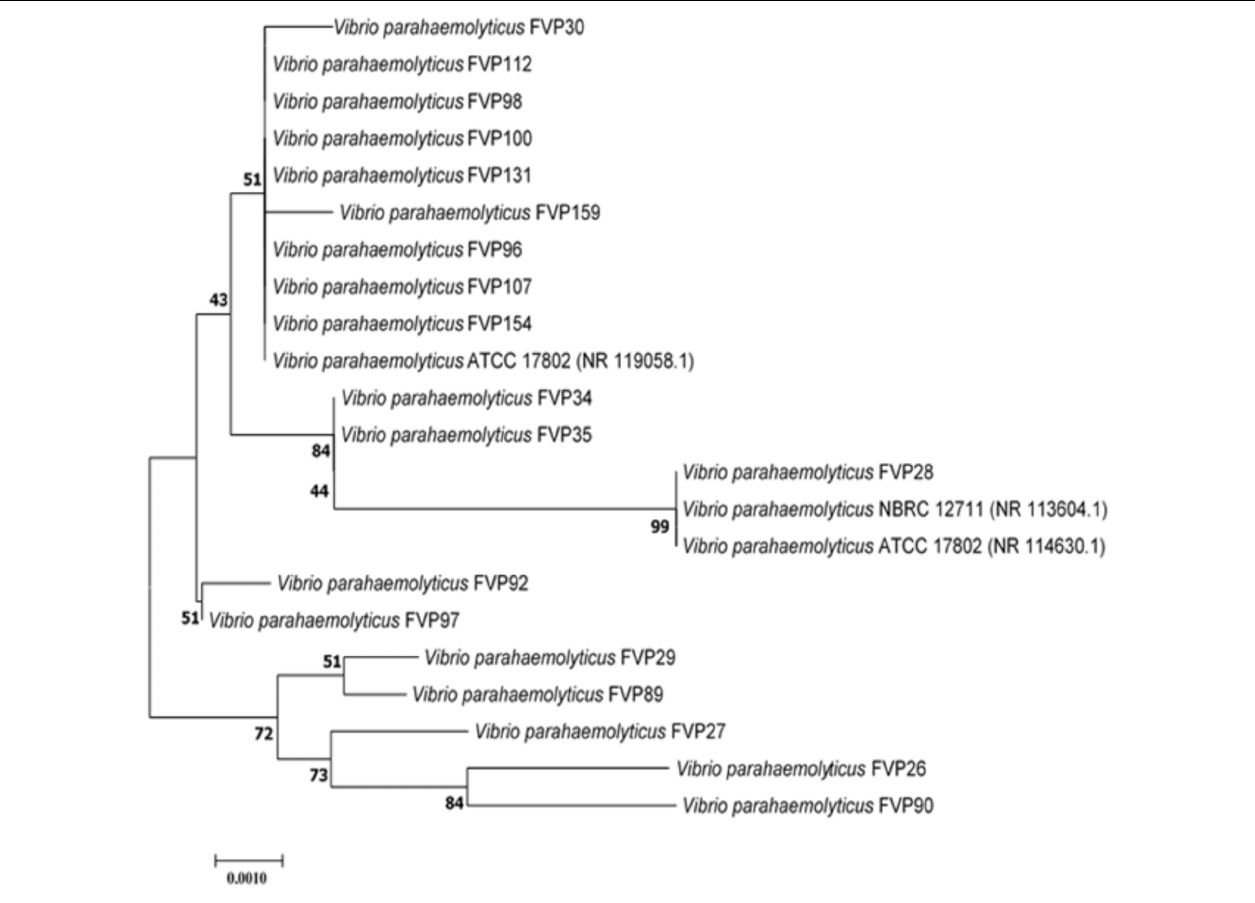
FIGURE 1 | Neighbor-joining phylogenetic tree based on almost complete 16S rRNA sequences showing the relationship between 19-imipenem resistant isolate and representatives of some other related taxa. Numbers at nodes indicate percentages of 1,000 bootstrap re-samplings. Bar: 0.0010 substitutions per site.